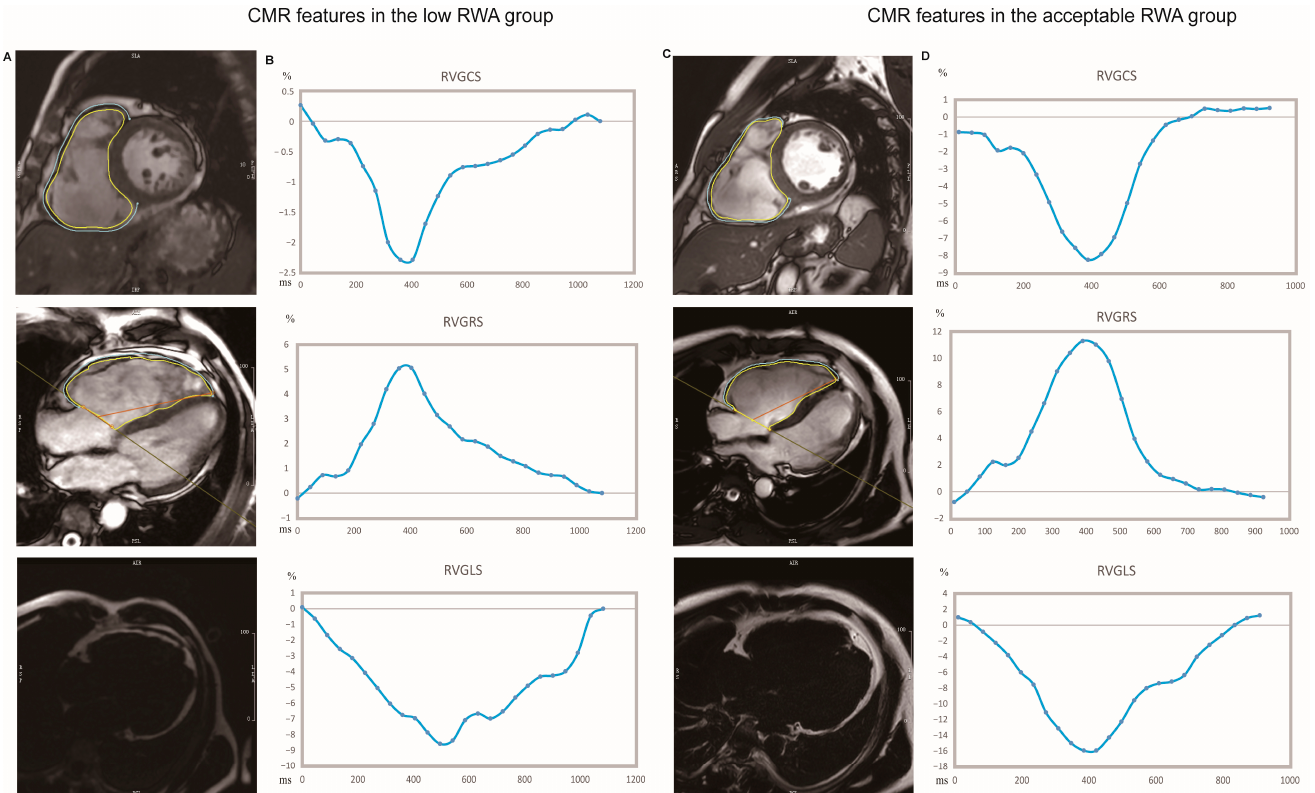
Figure 1. Representative CMR images of RV stain and fat infiltration from ACM patients with and without unfavorable R wave amplitude at ICD implantation. ( A , B ) Representative images and strain pattern from an ACM patient with low RWA (R wave amplitude of 3.6 mV at intrinsic sinus rhythm). ( C , D ) Representative images and strain pattern from an ACM patient with acceptable RWA (R wave amplitude of 11.7 mV at intrinsic sinus rhythm). Measurement of RV strain by CMR feature–tracking were displayed in ( A , C ) (upper and mid panel). The endo (yellow) and epicardial (blue) contours were delineated at the end ‐ diastole phase. The RV global radial and circumferential strain (GCS, GRS) were obtained from the short ‐ axis (( A , C ) Upper panel), while the global longitu ‐ dinal strain was measured from 4 ‐ chamber view (( A , C ) mid), respectively. The lower peak circum ‐ ferential (( B , D ) upper panel), radial (( B , D ) mid panel), and longitudinal (( B , D ) lower panel) strain of the right ventricle demonstrated more severe abnormalities of the RV strain in the patient with final low RWA. CMR images from mDixon’s water ‐ fat separation imaging were displayed at ( A , C ) (lower panel).